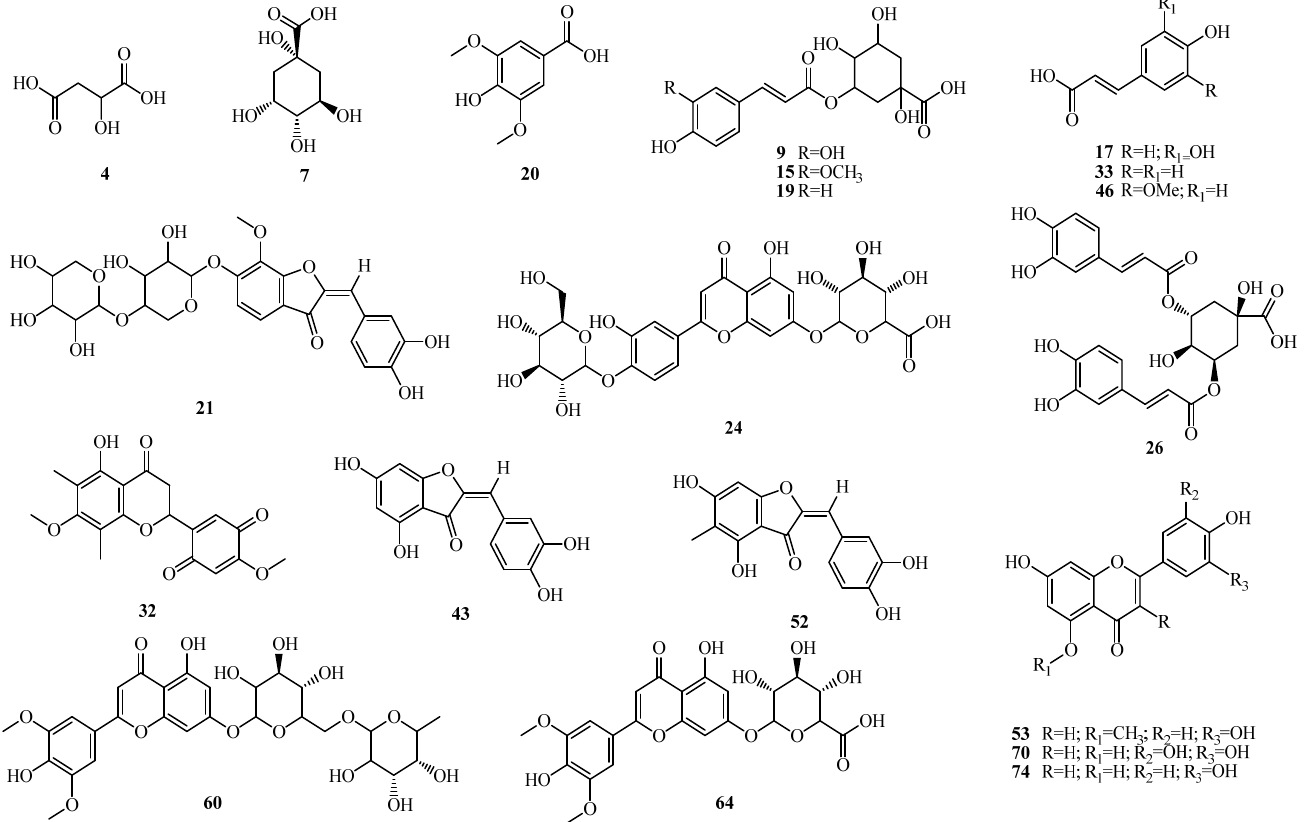
Table 1. Metabolites profiling of CLEE via UPLC-QTOF–MS/MS analysis in negative ion mode.